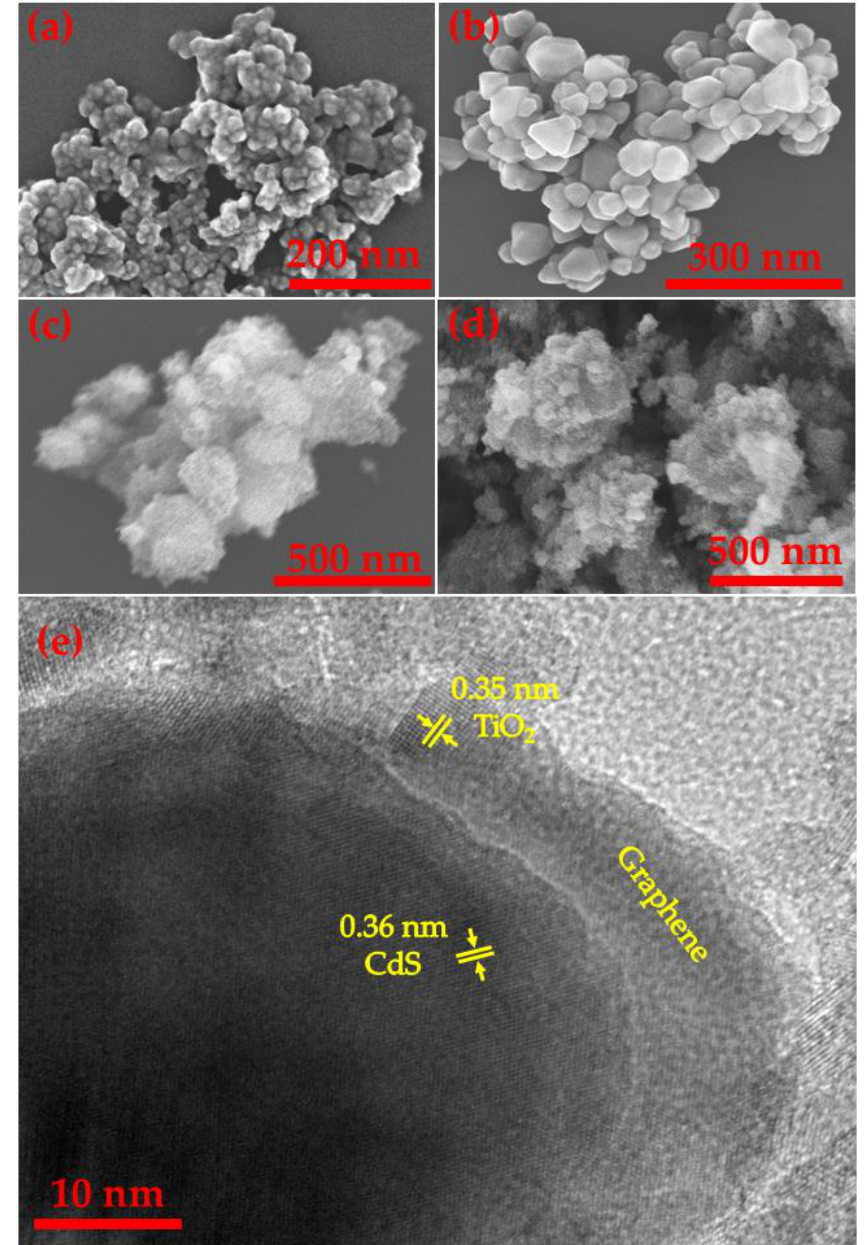
Figure 2. FE-SEM images of pure TiO 2 ( a ), pure CdS ( b ), CdS@TiO 2 ( c ), CdS@50G@TiO 2 ( d ) and HR- TEM images of CdS@50G@TiO 2 with lattice spacing ( e